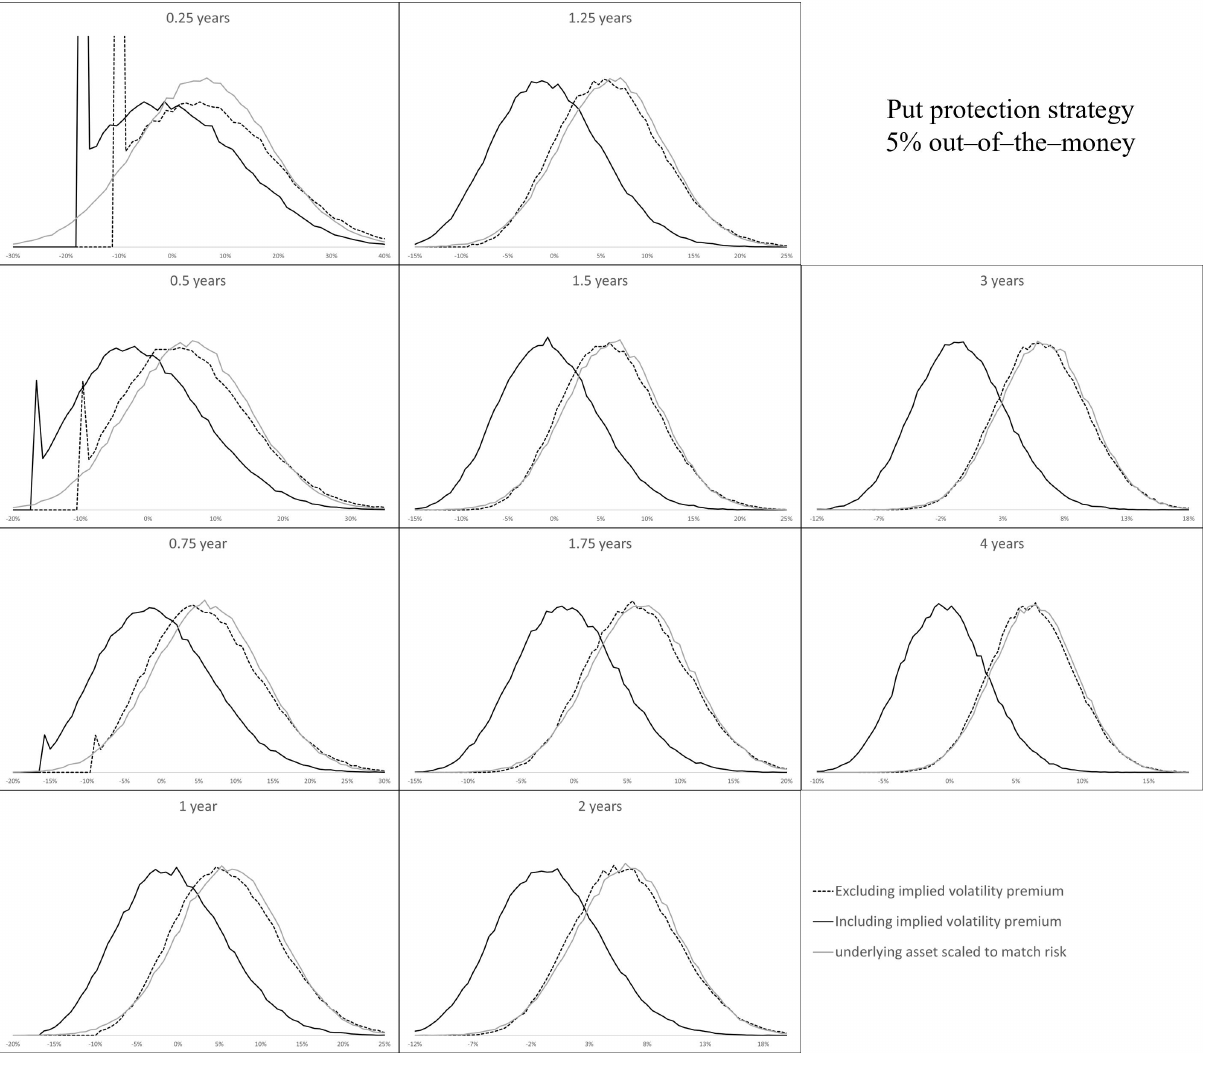
Figure 22. Simulations of the long-run returns of an underlying asset overlaid with a quarterly 5% out-of-the-money call overwriting strategy over investment horizons of 1 / 4 year, 1 / 2 year, 3 / 4 year, implied volatility is equal to the underlying asset volatility. The solid line includes the implied volatility premium in the price of the options. The gray line shows the long-run returns of a portfolio consisting of the risk-free asset and the underlying asset weighted to have the same risk as the option